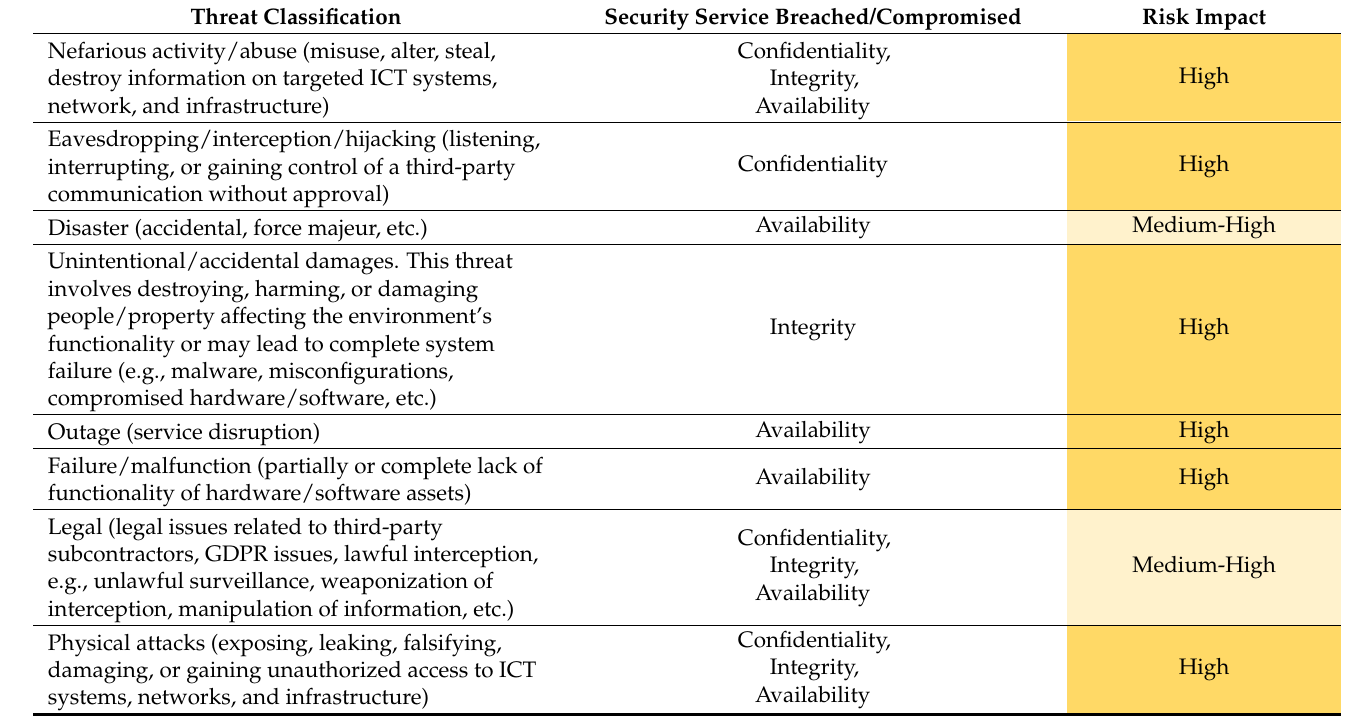
Table 1. ENISA’s threat classification for